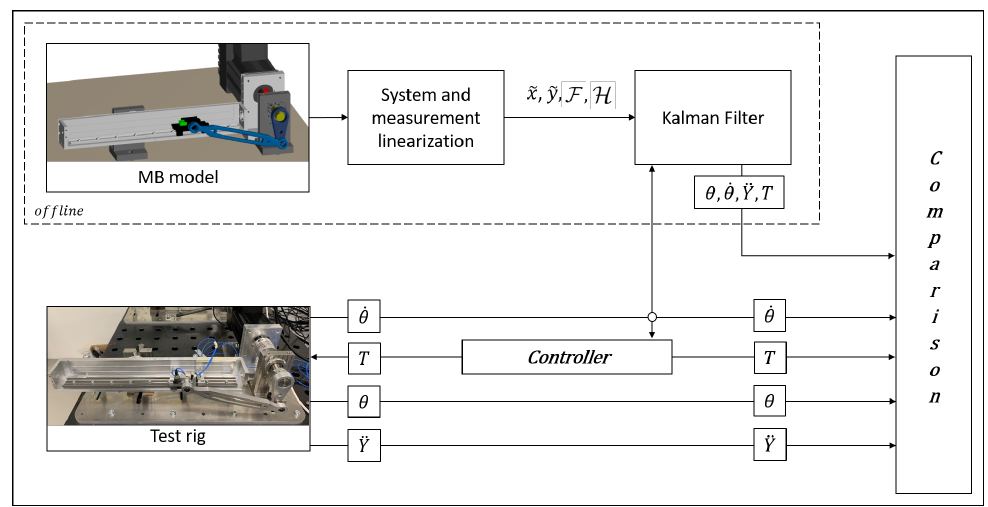
Figure 5. Diagram of the coupled state-input estimation scheme and signal comparisons. θ and ˙ θ are the motor angle and angular motor velocity respectively; ¨ Y is the translational slider acceleration; T is the motor